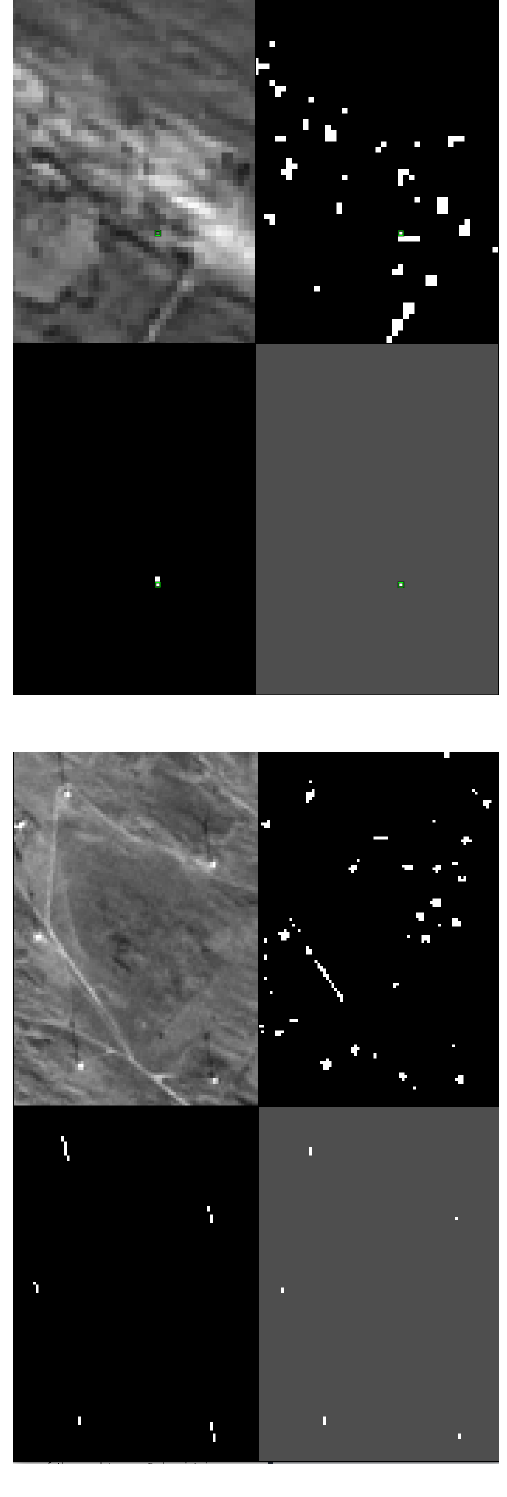
Figure 4. Two panels of detections of our algorithm, ϵ = 1 . The first panel shows a false positive highlighted by a green square, the second panel shows some true positives. On both panels, the first image is the blue channel of the Sentinel-2 scene in November, the top right is the hub detection map, the bottom left one is the shadow detection map, the last one is the detection map. On the detection maps, white pixels are detected, black ones are